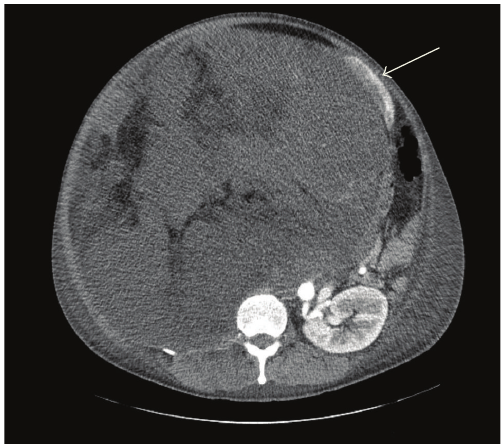
Figure 1: Computerized tomography detected a 43 × 37 × 31- cm tumor in the right retroperitoneum, and the right kidney was deflected greatly to the left ventral side (white arrow).